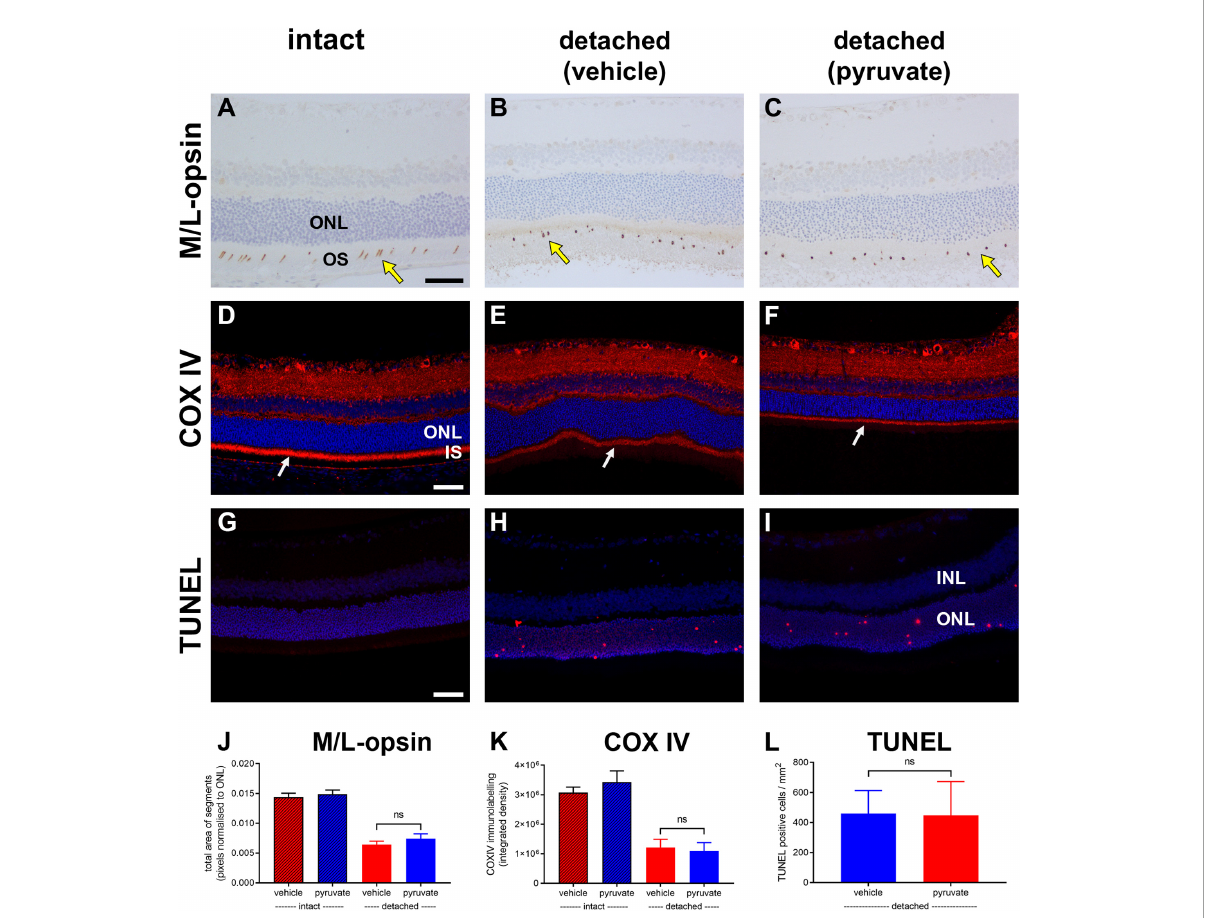
FIGURE11 Short-term pyruvate supplementation fails to protect against photoreceptor degenerative changes at 3 days after retinal detachment. (A–I) Representative images of M/L-opsin immunolabelling (yellow arrows), COX IV immunolabelling (white arrows), and TUNEL labelling in intact retina (A,D,G) and at 3 days after detachment in rats administered normal (B,E,H) or pyruvate-supplemented (C,F,I) drinking water. Scale bars: 60 µ m. INL, inner nuclear layer; IS, inner segments; ONL, outer nuclear layer. (J–L) Quantification of total area of M/L-opsin immunolabelling (J) , abundance of COX IV immunoreactivity associated with photoreceptor inner segments (K) , and the number of TUNEL-positive cells in the ONL (L) . All values represent mean ±